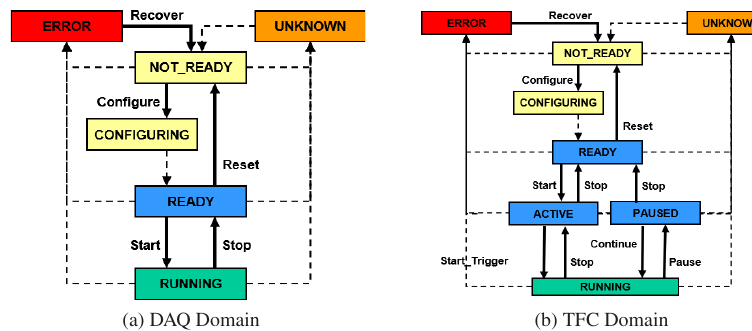
Figure 5. FSM Domains provided in the fwMiniDAQ